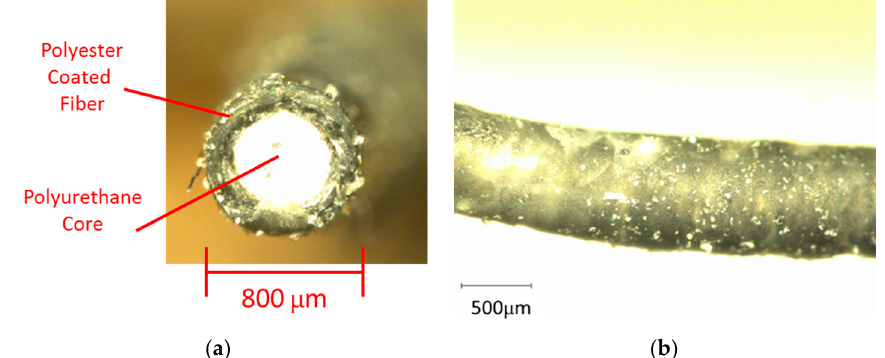
Figure 2. Microscopic images of obtained fibers after coating and sealing process: ( a ) Cross section showing coated polyester fibers rounding a polyurethane core; ( b ) Longitudinal image showing effective latex